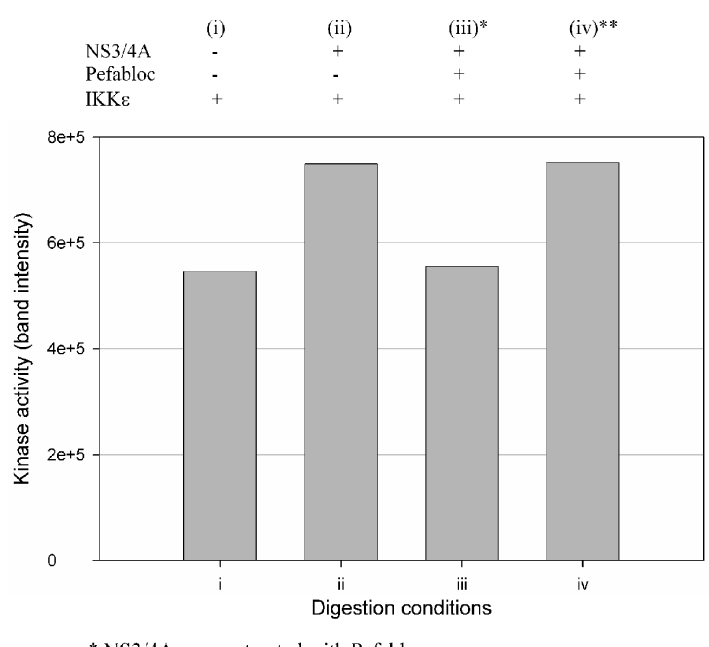
Figure 8. Effect of Pefabloc SC on the capability of NS3/NS4A to enhance the kinase activity of IKK ε . Pefabloc SC was added at the beginning of the 15 min preincubation of NS3 and NS4A (1.25 μ M NS3 + 325 μ M NS4A) at 23 °C (before addition of IKK ε ) or after the reaction was completed (prior µ M NS3 + 325 µ M NS4A) at 23 ◦ C (before addition of IKK ε ) or after the reaction was to the flash-freezing step). Four reaction conditions were set up: (i) IKK ε not treated with NS3/NS4A; (1.25